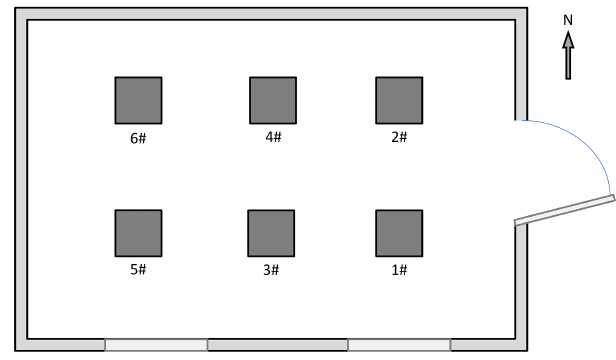
Figure 1. The layout of the absolute measurement